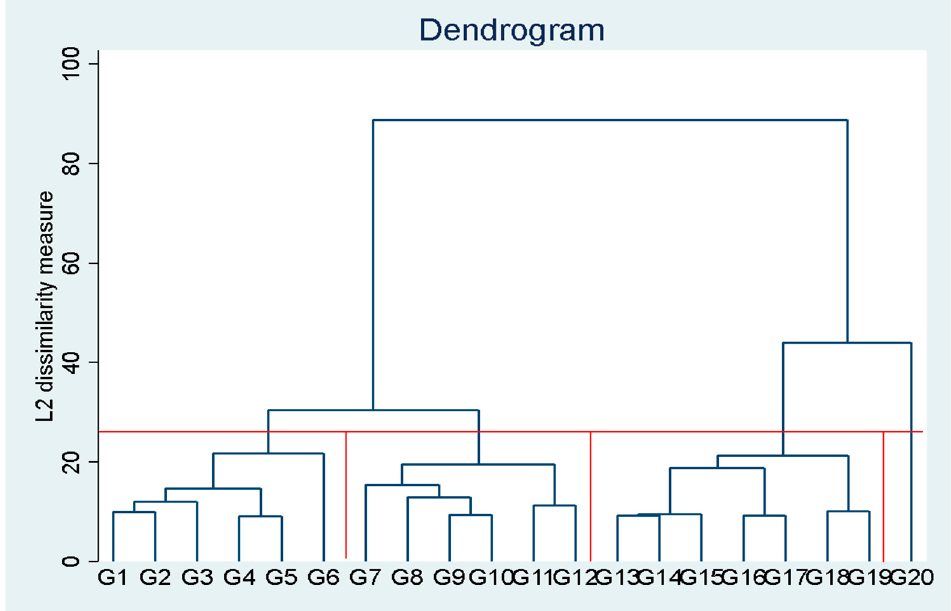
Figure 1. Dendrogram for the cluster solution. Table 1. Eigenvalues results for discriminant analysis.